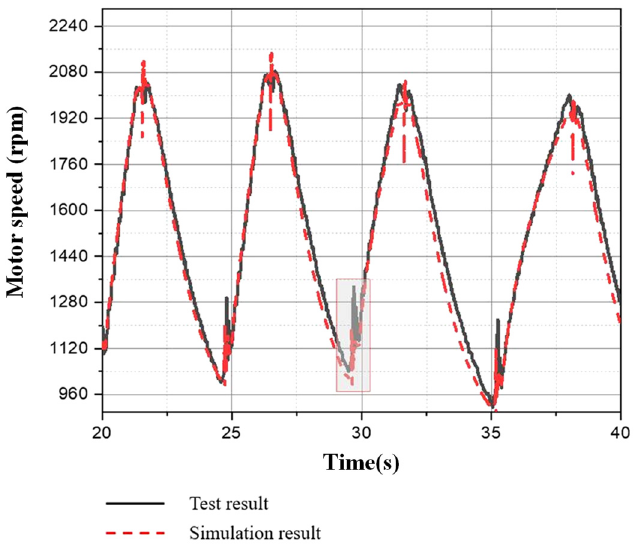
Figure 8. Contrast between the simulated motor speed and the measured speed under multiple tip-in/out conditions.